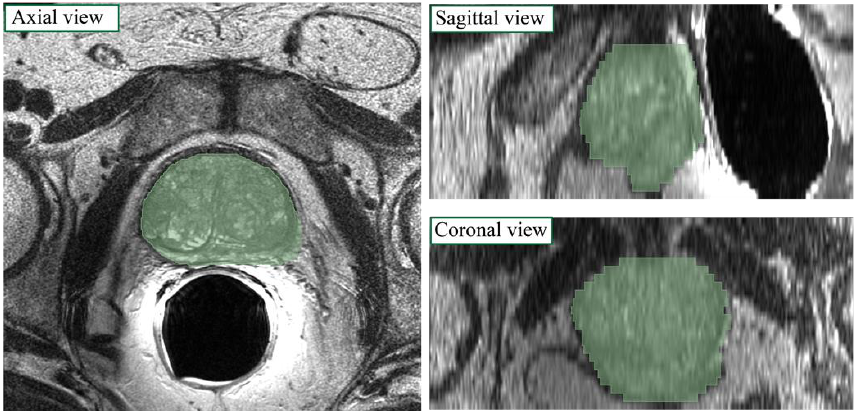
Figure 1. Manual label superimposed on MRI image in axial, sagittal and coronal views for a sample patient.